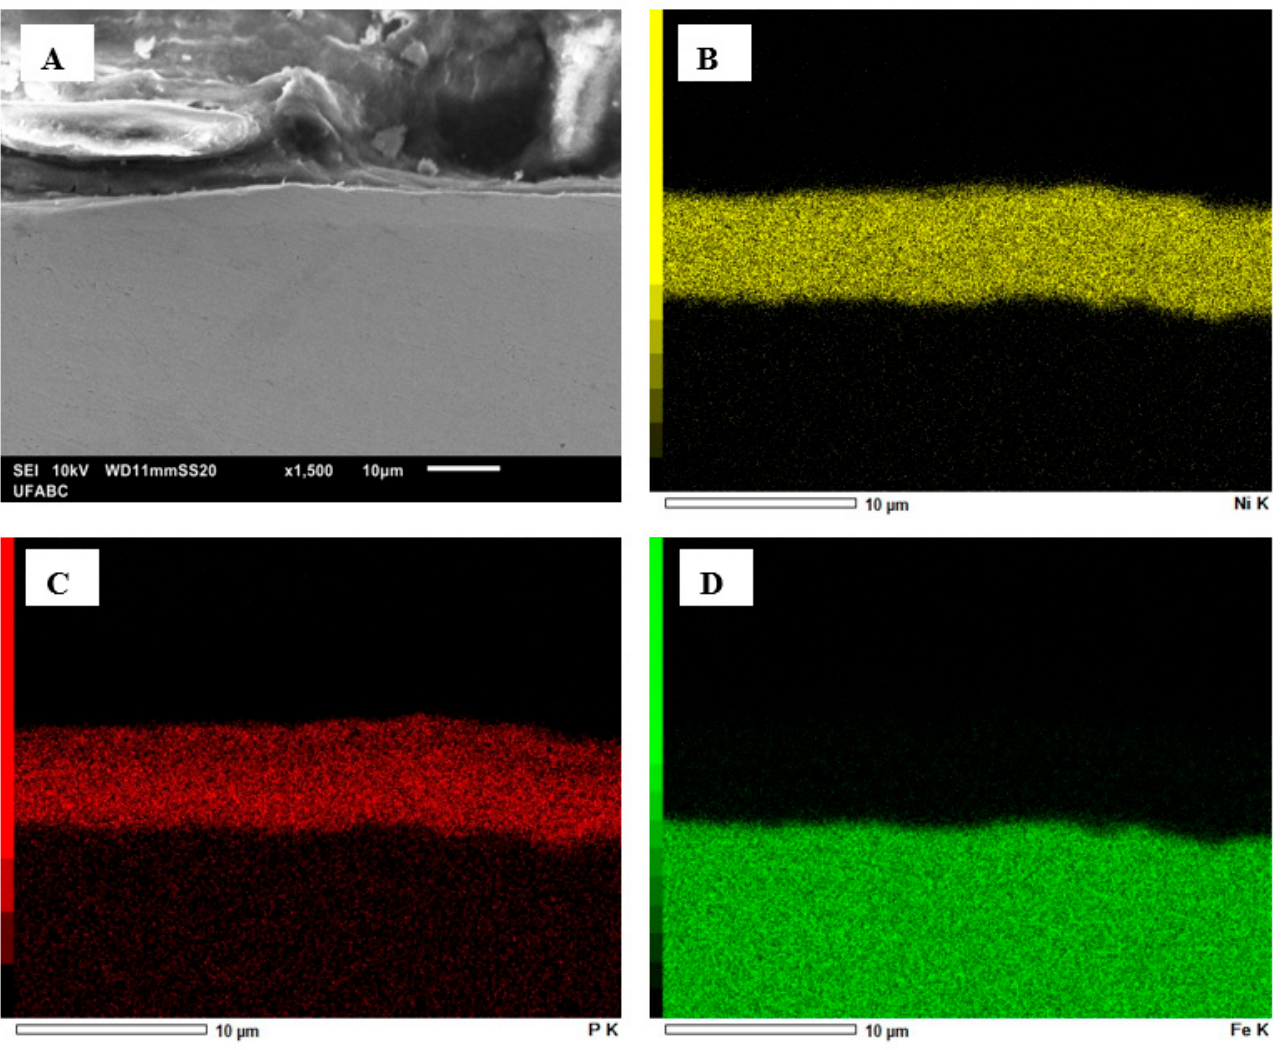
Figure 3. EDS mapping of the cross-sections for CNT-0.25: ( A ) SEM micrograph; ( B ) Ni; ( C ) P; ( D ) Fe.